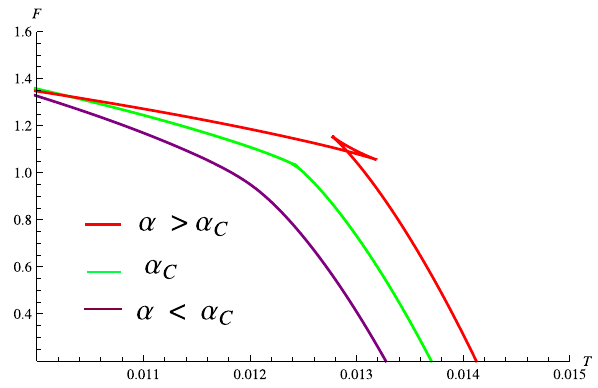
Fig. 4 The relationship between temperature T versus the free energy F for varying α for the case l = 20 for neutral Gauss–Bonnet AdS black hole in four